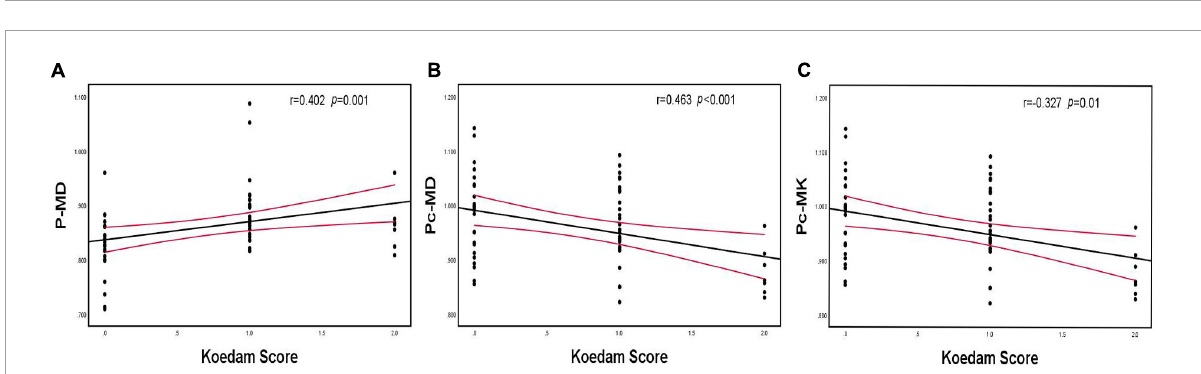
FIGURE6 Spearman’s correlation analysis between MD and MK of the parietal lobe and precuneus and Koedam scores. (A) Parietal MD was positively correlated with Koedam scores, (B) Precuneus MD was positively correlated with Koedam scores, (C) Precuneus MK was negatively correlated with Koedam scores. P-MD, mean diffusivity of parietal lobe; Pc-MD, mean diffusivity of precuneus; Pc-MK, mean kurtosis of precuneus.